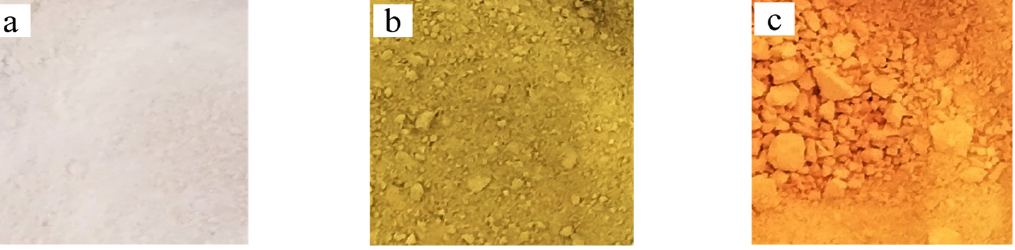
Figure 1. Colors of the synthesized materials: ( a ) (TBA) 3 PW, ( b ) (TBA) 4 PWV, ( c ) (TBA) 5 PWV 2 .